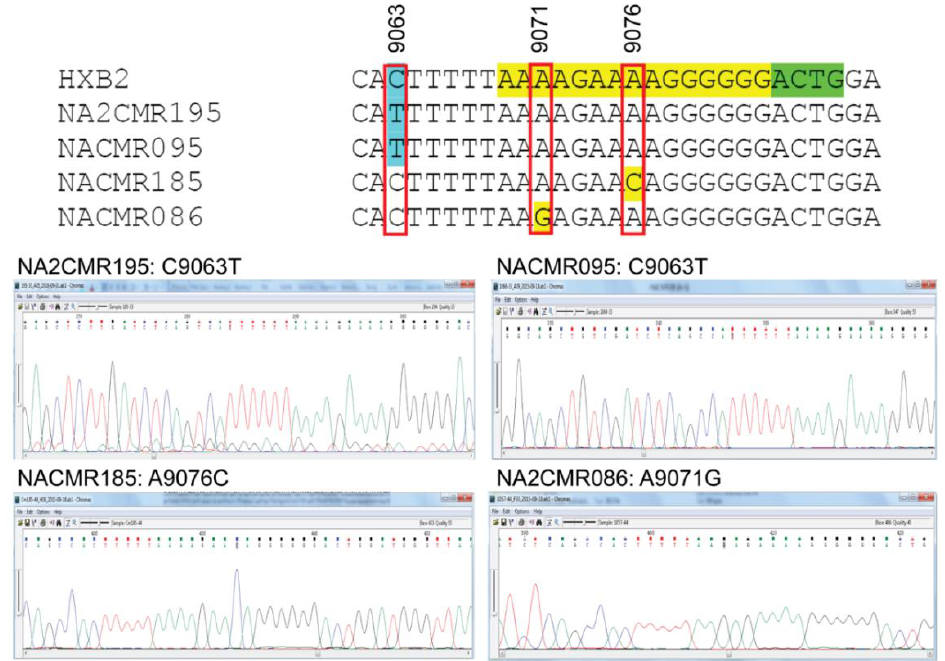
Figure 4. Mutations detected in the 3 (cid:48) polypurine tract (3 (cid:48) -PPT) and its flanking regions for cohort samples. Nucleotide sequences alignments, using HXB2 as a reference sequence, are shown for the four study cohort samples in which mutations were detected. The 15 nucleotides of 3 (cid:48) -PPT sequences are shaded yellow. The 1st four nucleotides of 3 (cid:48) LTR are shaded green. Region with mutation upstream of the 3-PPT (nucleotide position 9063) is shaded in sky blue. Nucleotide numbers correspond to the numbering of the HXB2 reference sequence. Electropherograms showing data sequences and mutations are shown for the four cohort